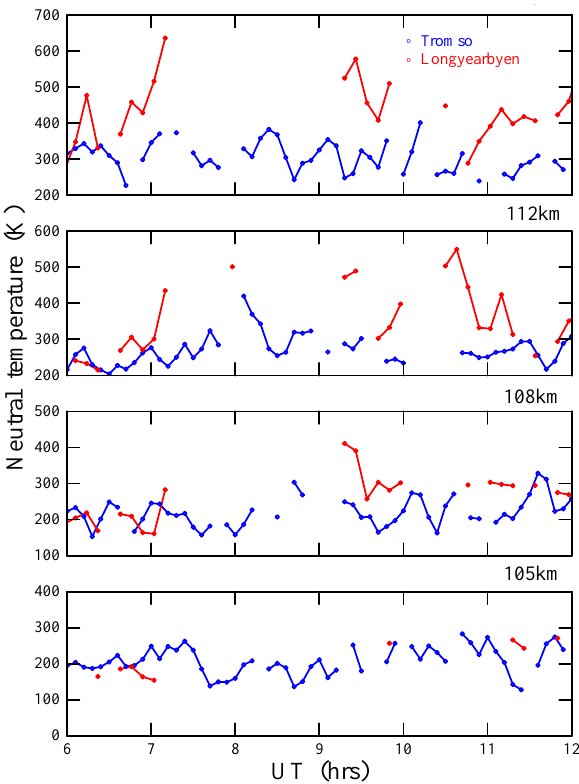
Fig. 11. same as Fig. 10 except for 9 March 1999.